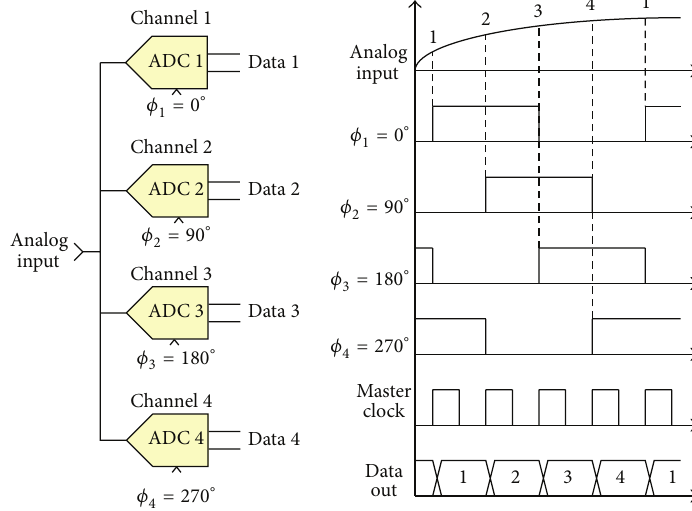
Figure 5: Time interleaved ADCs for broadband